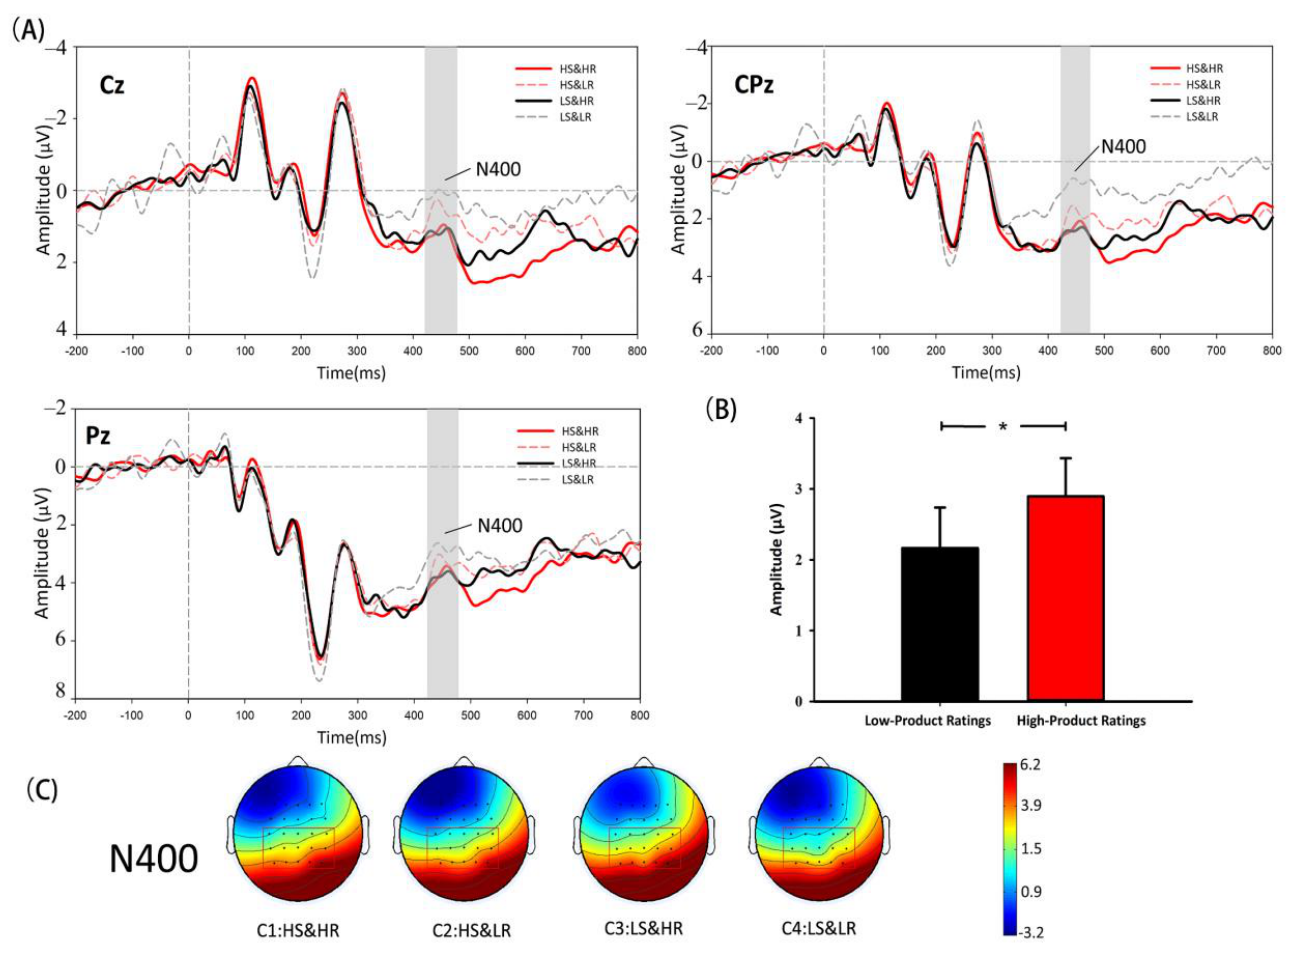
Figure 4. ( A ) Waveform diagrams of N400 component. ( B ) ANOVA results of N400. ( C ) Scalp topographic maps of N400 corresponding to four conditions. Note: * p < 0.05.